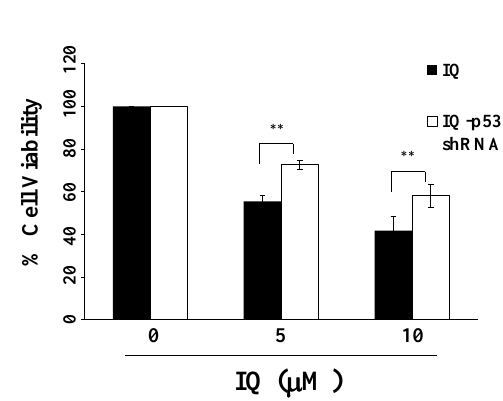
Figure 3. E ff ect of IQ on various biomarkers in SCC4 cells. ( A ) Phosphorylation / expression of Akt, p38, Bax, Mcl-1, Bcl-2, and survivin in SCC4 cells. Cells were treated with IQ for 48 h, and cell lysates were immunoblotted as described in Materials and Methods. ( B ) Expression of p-p53 and p53 of IQ in SCC4 cells. ( C ) Western blotting of p-p53 and p53 in SCC4 cells transiently transfected with a control vector or p53 shRNA for 24 h. ( D ) IQ-induced cell viability in p53 knockdown SCC4 cells. After incubation, cells were analyzed using the MTT assays. Columns, mean; bars, S.D. ** p <